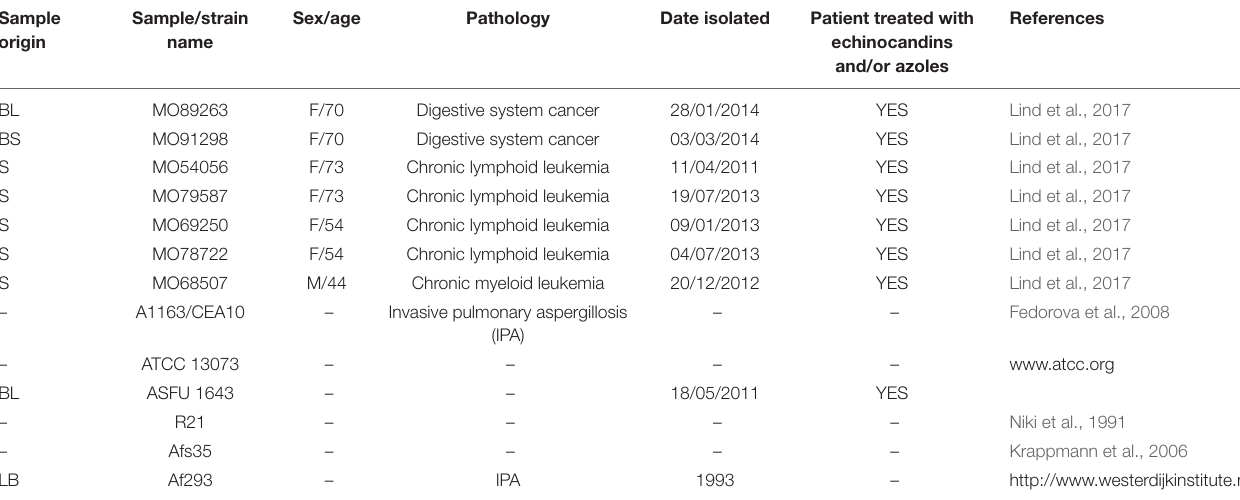
TABLE 1 | Names and origin of clinical isolates used in this